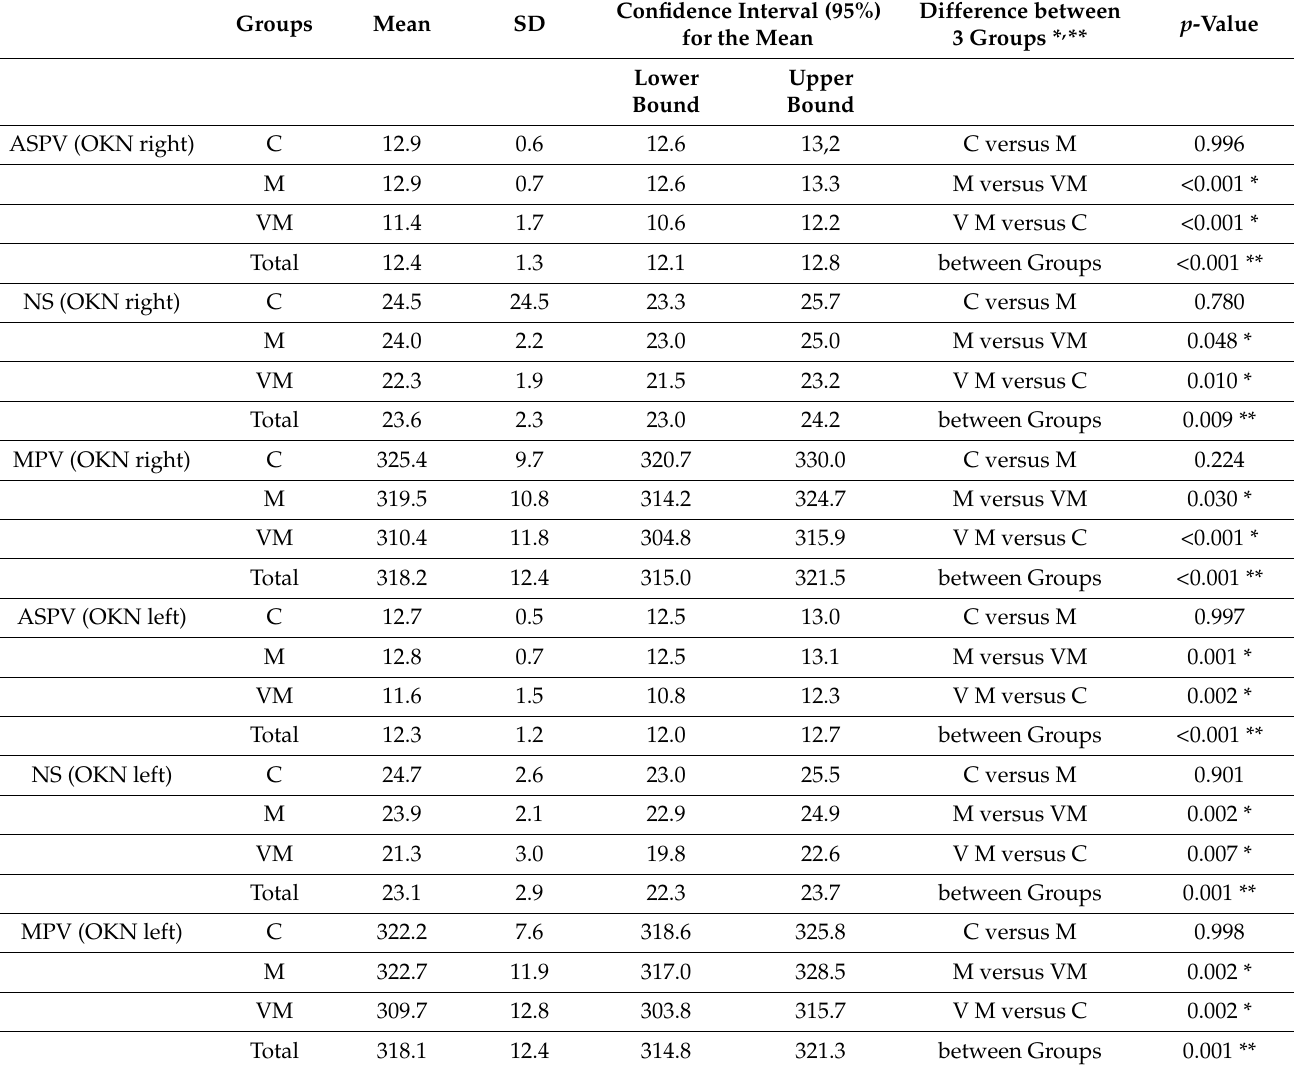
Table 3. Optokinetic reflexes parameters recorded by electronystagmography during the two stabilo- metric tests performed with optokinetic horizontal